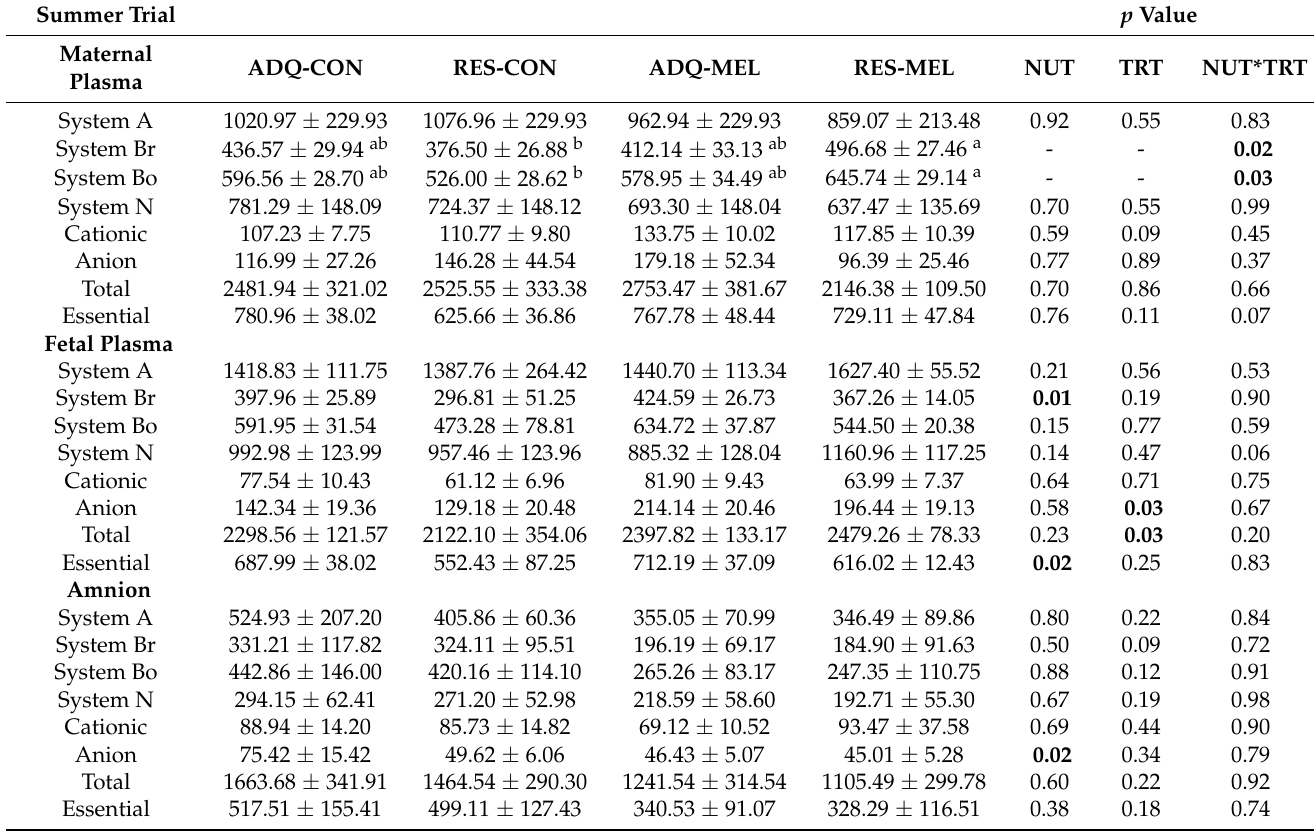
Table 3. Amino acids in maternal and fetal plasma, and amnion by transport system, total amino acids, and essential amino acids in the summer